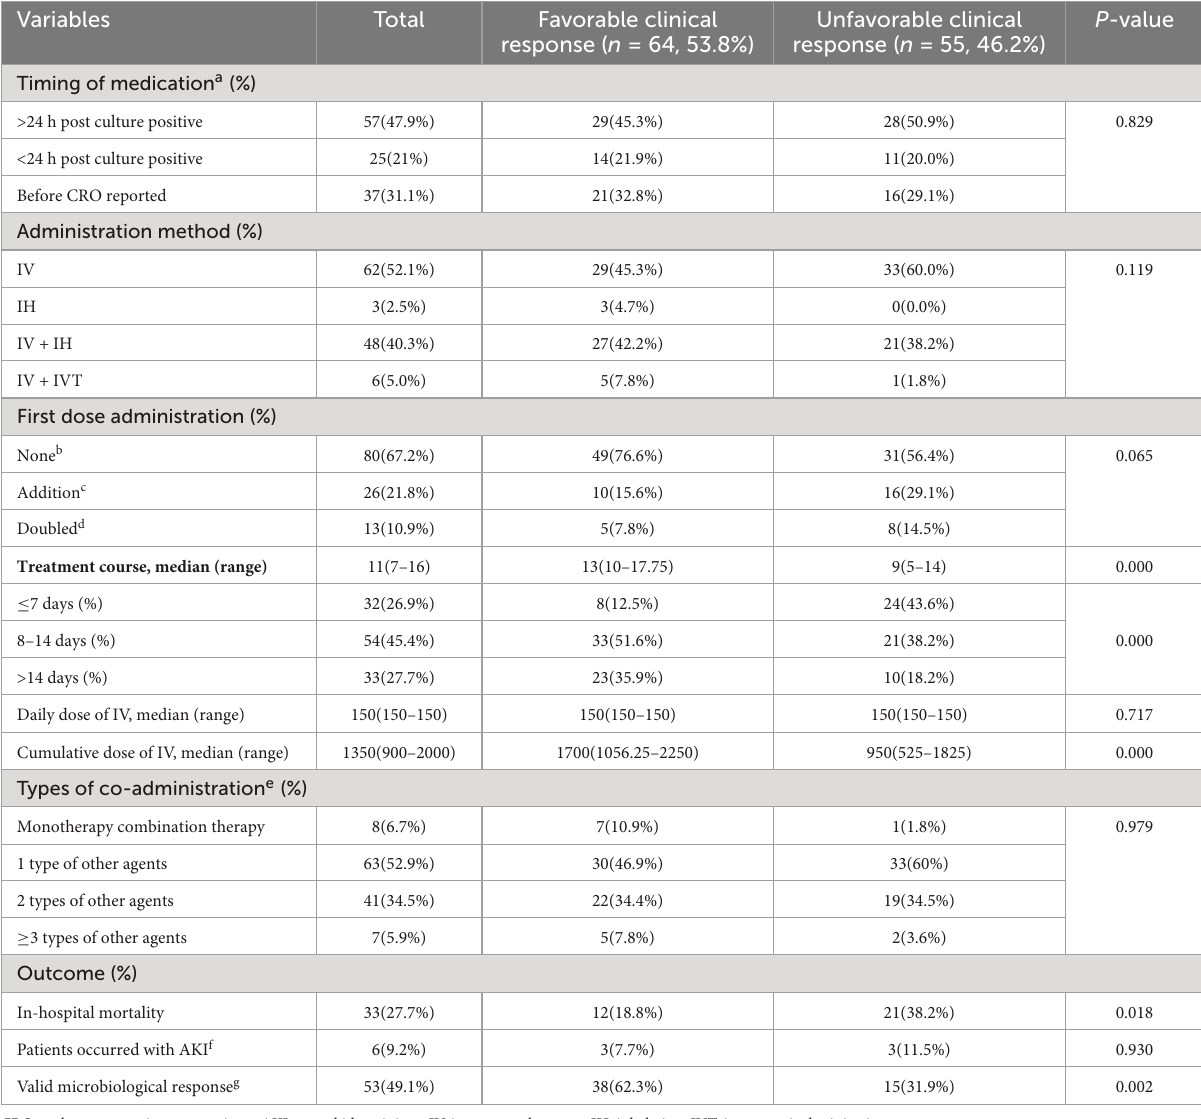
TABLE 3 The treatment methods of polymyxin E sulfate and outcomes based on different clinical